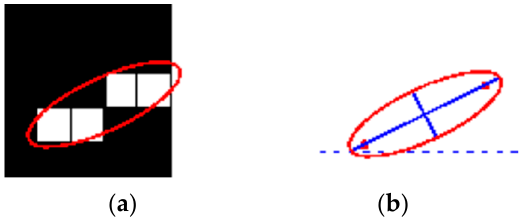
Figure 8. ( a ) Ellipse fitting the pixels, ( b ) the angle between the x -axis and major axis of the fitted ellipse forms the orientation feature.